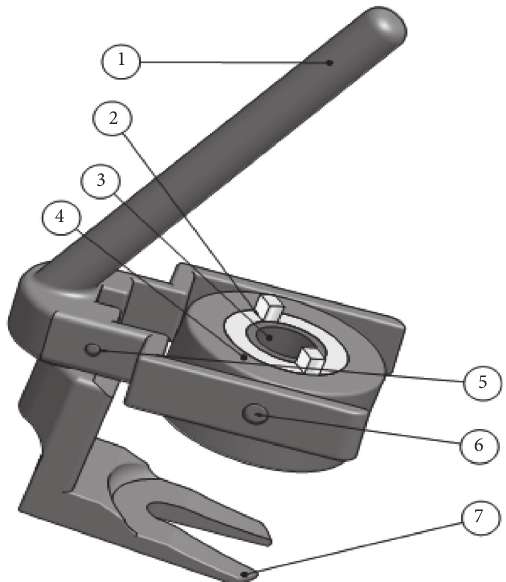
Figure 5: Proposed design of a poppet valve spring